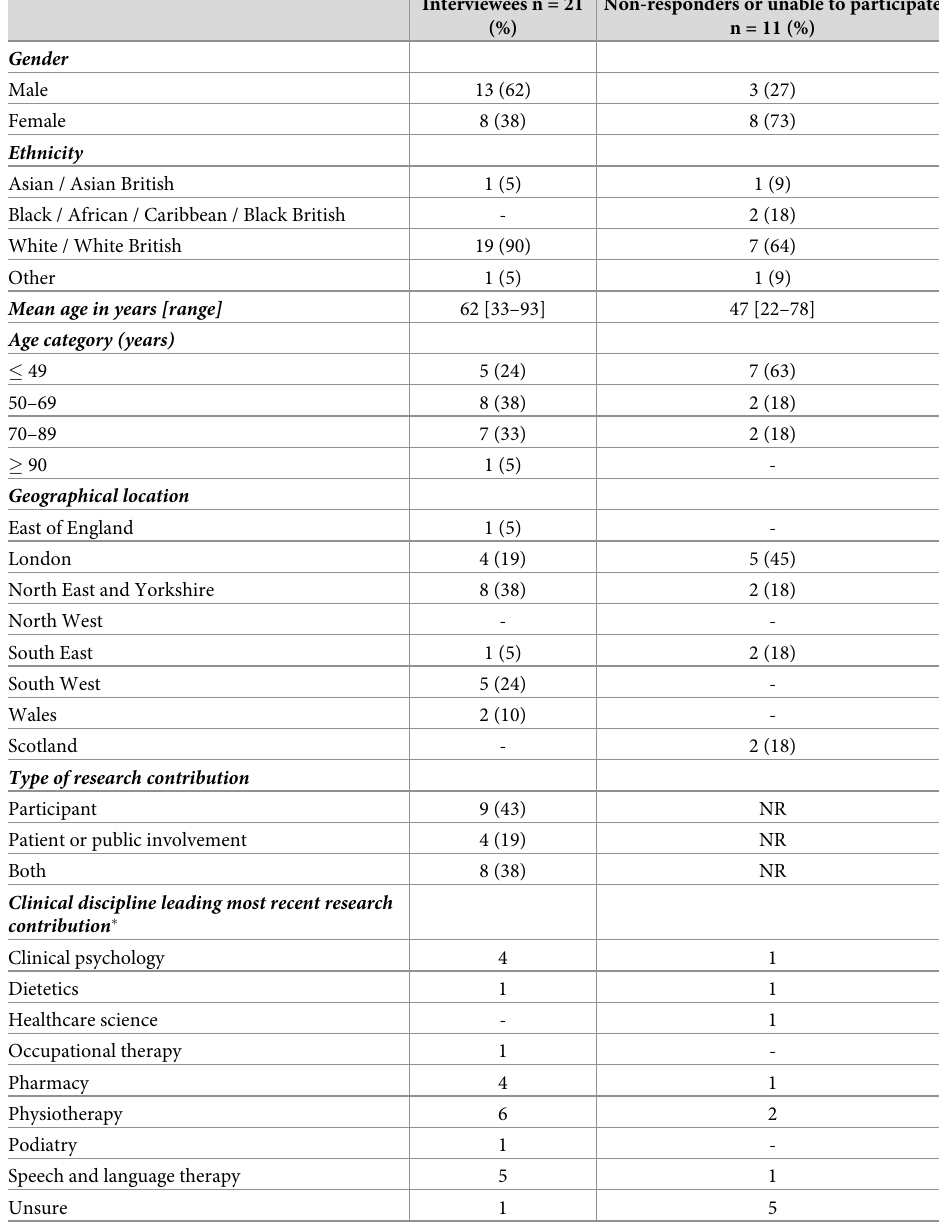
Table 2. Characteristics of interviewees compared with